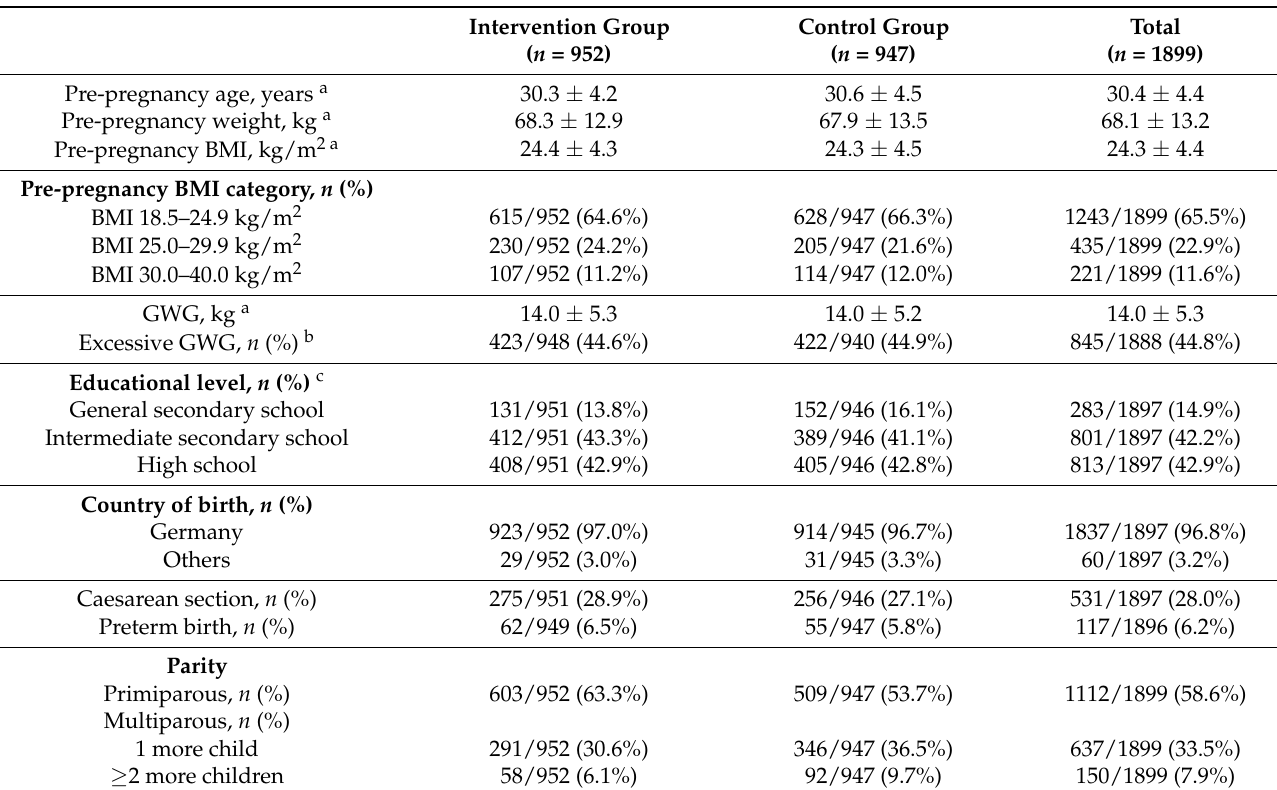
Table 1. Maternal